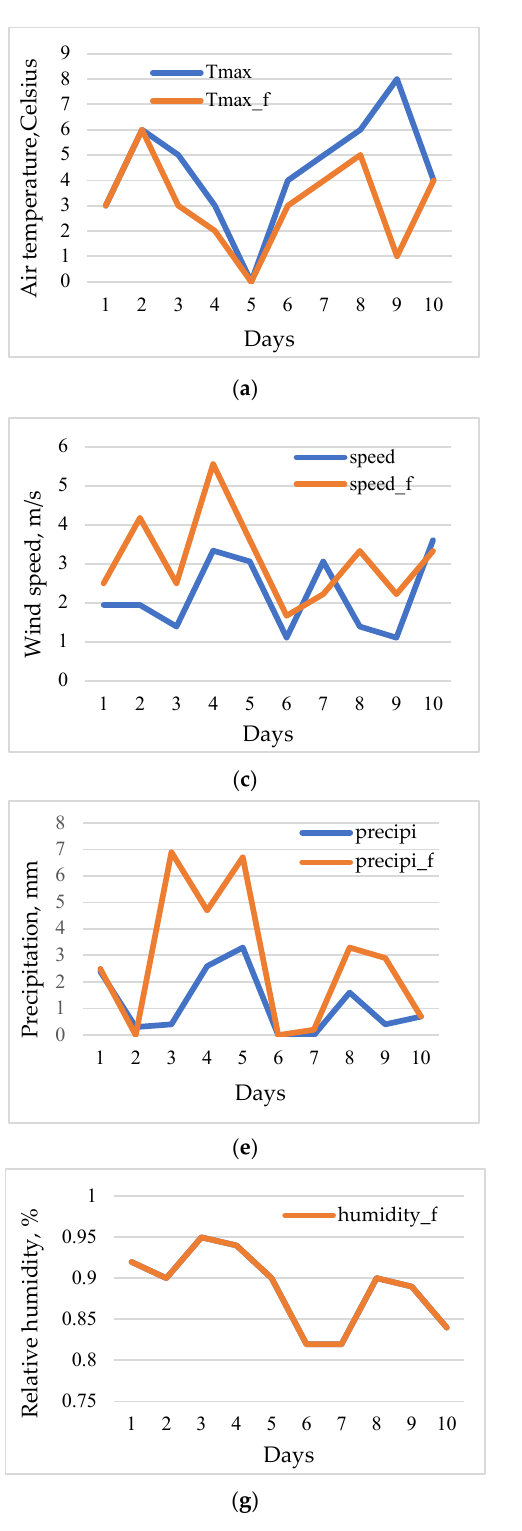
Figure 5. Measured meteorological values and their ex-ante weather forecasts (_f) for a 10-day horizon used in the multi-step procedure (example dataset): ( a ) MaxT, ( b ) MinT, ( c ) speed, ( d ) cloud, ( e ) precipi, ( f ) pressure, and ( g ) humidity.